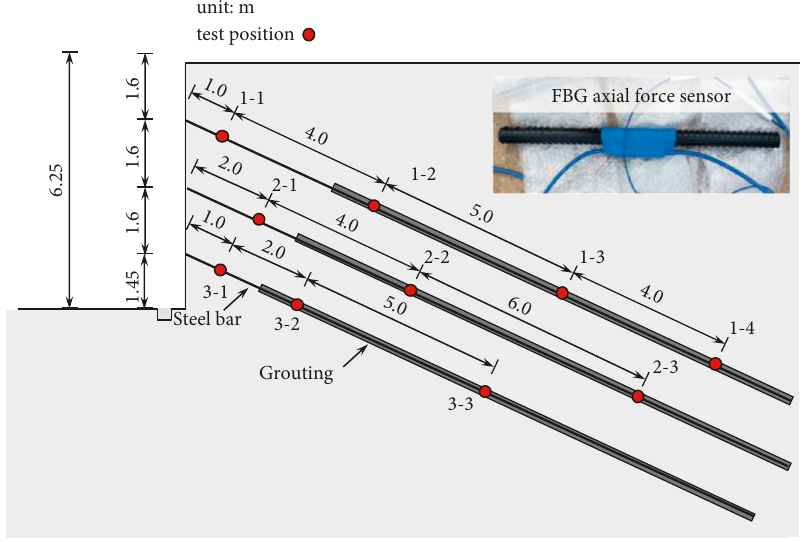
Figure 6: Anchor sensor